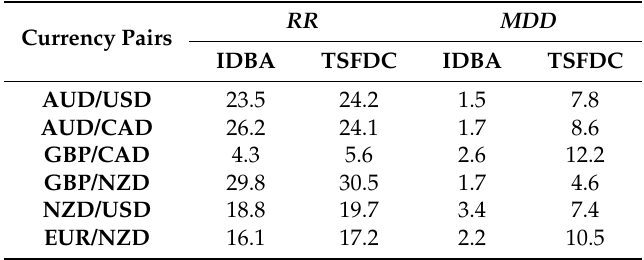
Table 12. Summary of RR and MDD of IDBA and TSFDC.